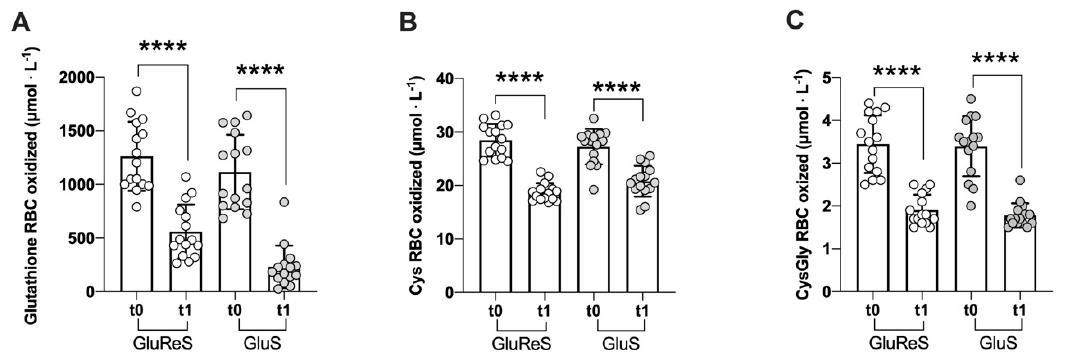
Figure 2. Scatter dot plot of oxidized thiol species measured in erythrocytes before (t0) and after eight weeks (t1) of dietary supplementation with GluReS or GluS. ( A ) oxidized glutathione, ( B ) cysteine (Cys), ( C ) cysteinylglycine (CysGly); RBC = red blood cells. Data are expressed as the mean ± SD. Change over time (t1 vs. t0) was significant at: **** p < 0.0001.